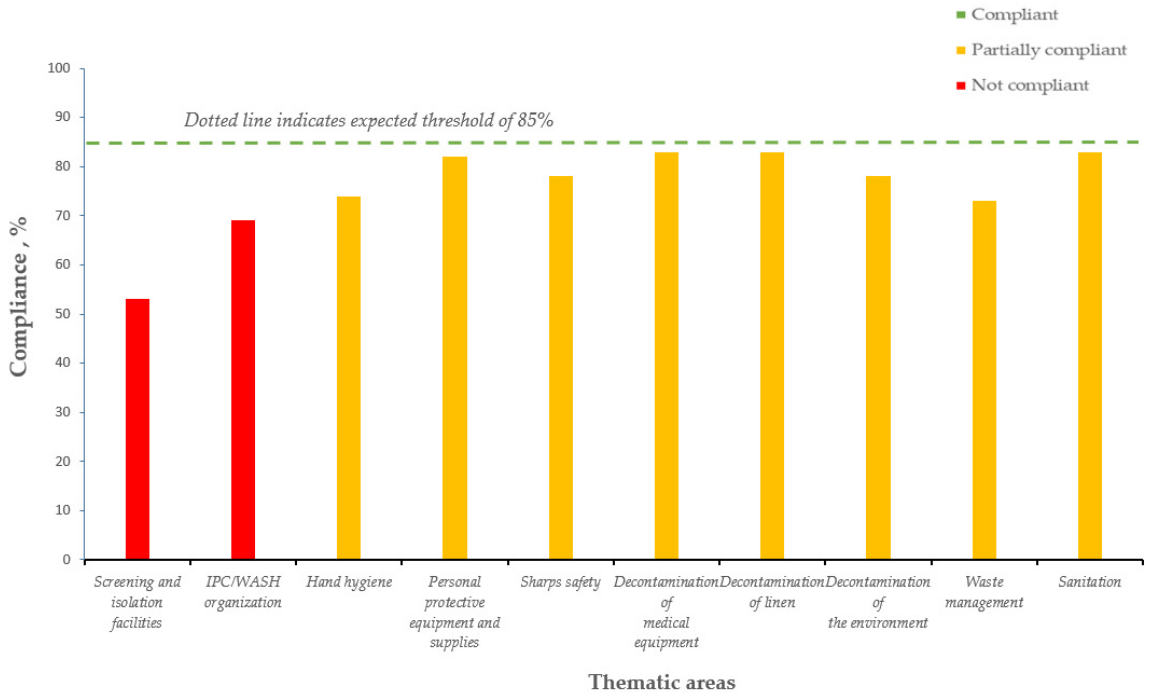
Figure 2. Average yearly IPC/WASH compliance (average of quarterly scores for the year, three quarters assessed) in the 10 thematic areas, Community Health Centers, Kenema district, Sierra Leone (2018). Table 3. Average yearly compliance in relation to scores on a National IPC/WASH 1 assessment tool in Community Health Posts, Kenema district Sierra Leone (2016–2018).